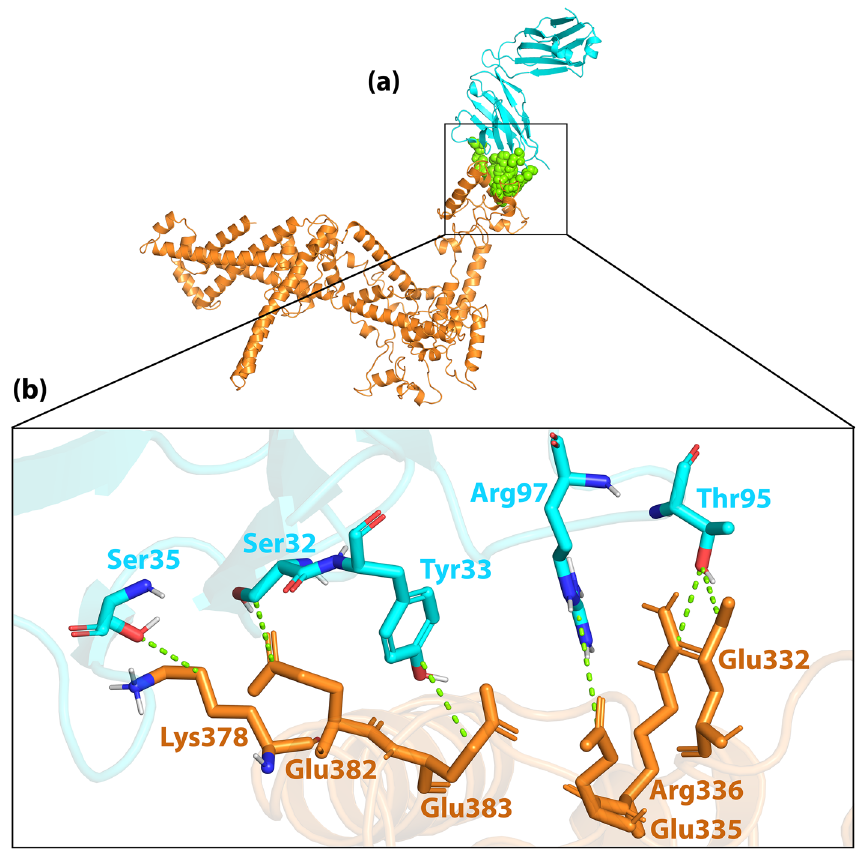
Figure 10. ( a ) Visualization of docking HADDOCK results for H7N9vac-m826 Light chain complex and ( b ) magnified residues interaction of H7N9vac-m826 Light chain complex. H7N9v structure is shown as the carton and sticks in copper color. TLR8 structure is shown as the carton and sticks in cyan color. Hydrogen bonds are shown as the green dashed line.